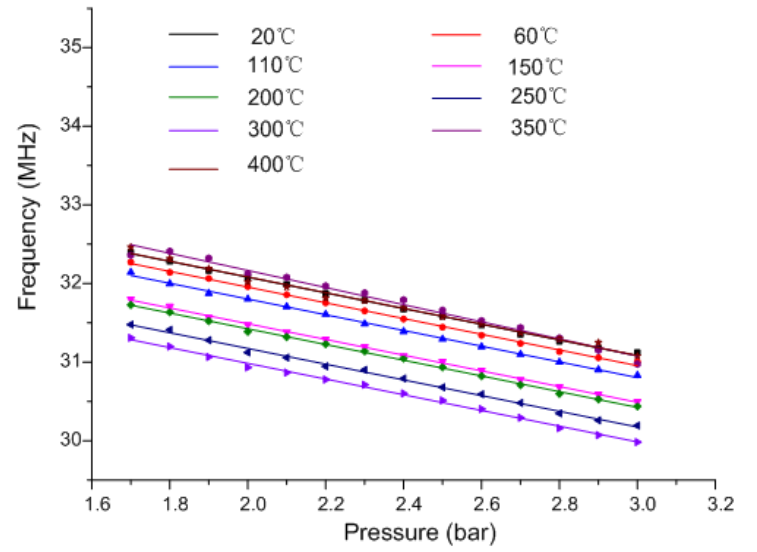
Figure 11. Measured curve of the pressure sensing element after temperature